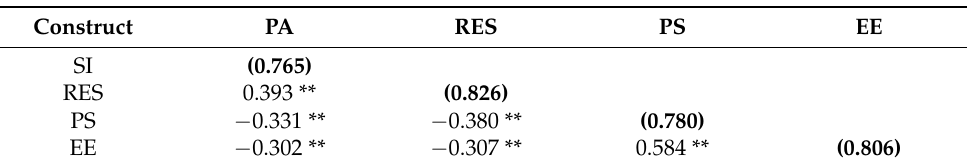
Table 3. Discriminant validity